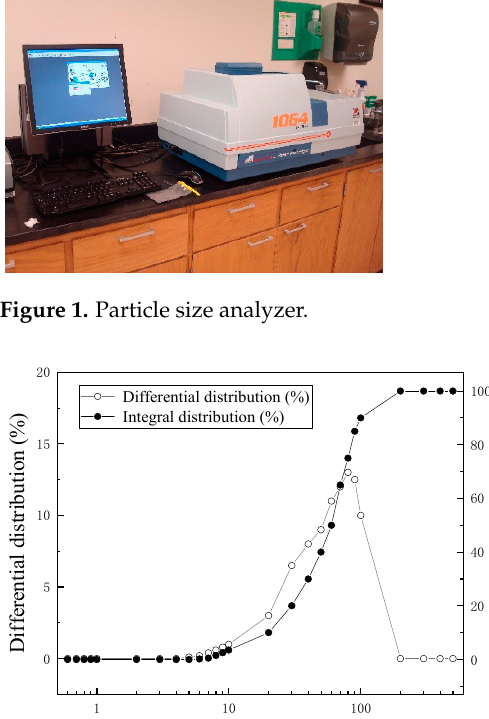
Figure 2. Grain size distribution curve of the whole tailing sand .